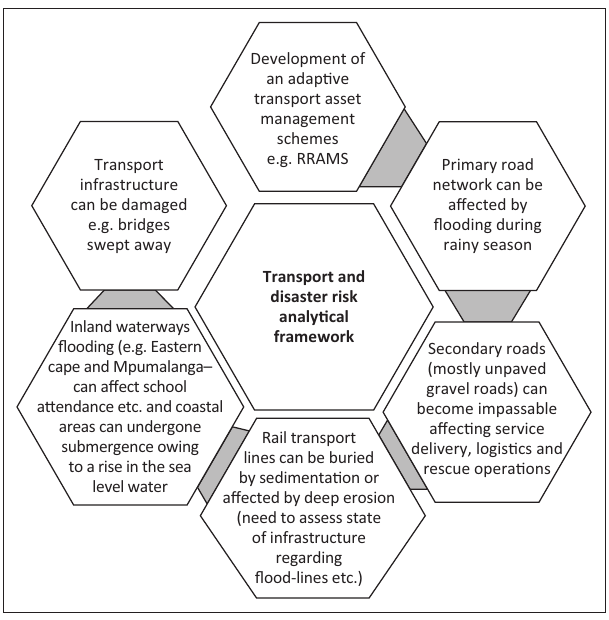
FIG URE 1: Transport and disaster risk analytical framework in South